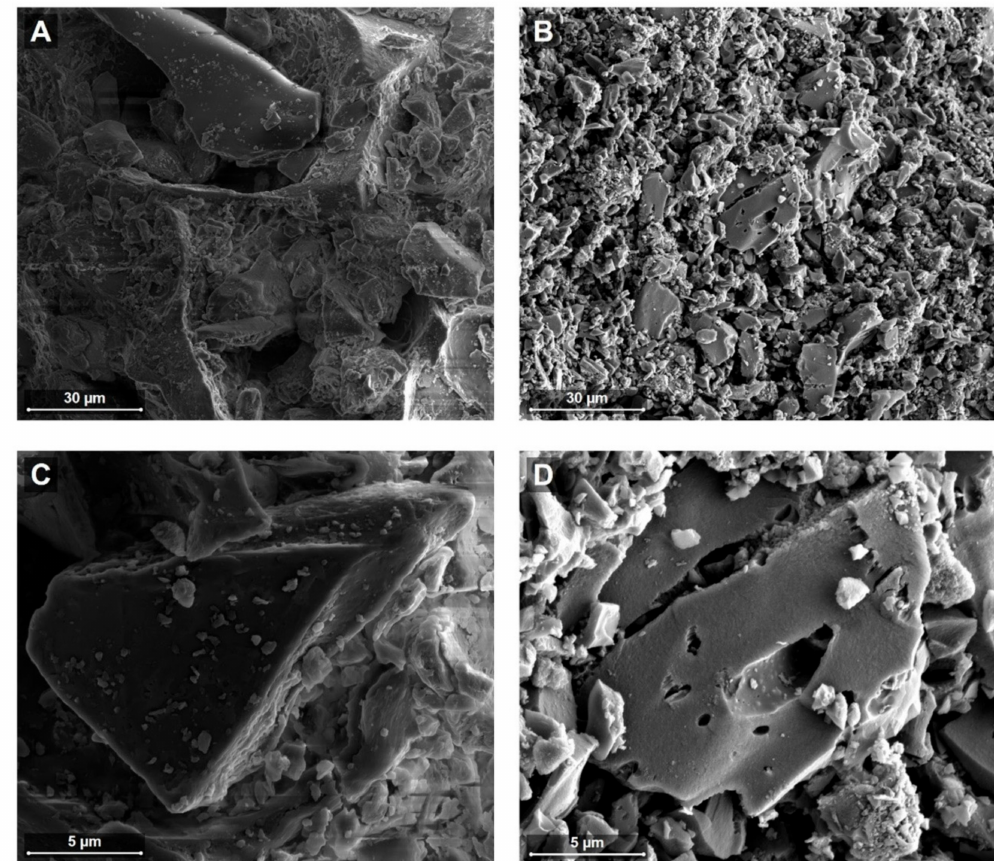
Figure 3. Scanning electron microscopic images of co ff ee charcoal ( A , C ) and activated charcoal ( B , D ) obtained with dual beam microscope (DBM) in the low voltage mode at 5 kV with horizontal field widths of 85.3 µ m ( A , B ) and 21.3 µ m ( C , D